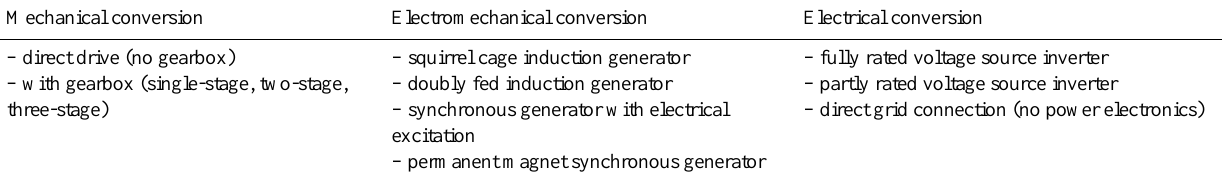
Table 2. Components of the electromechanical conversion system in state-of-the-art wind